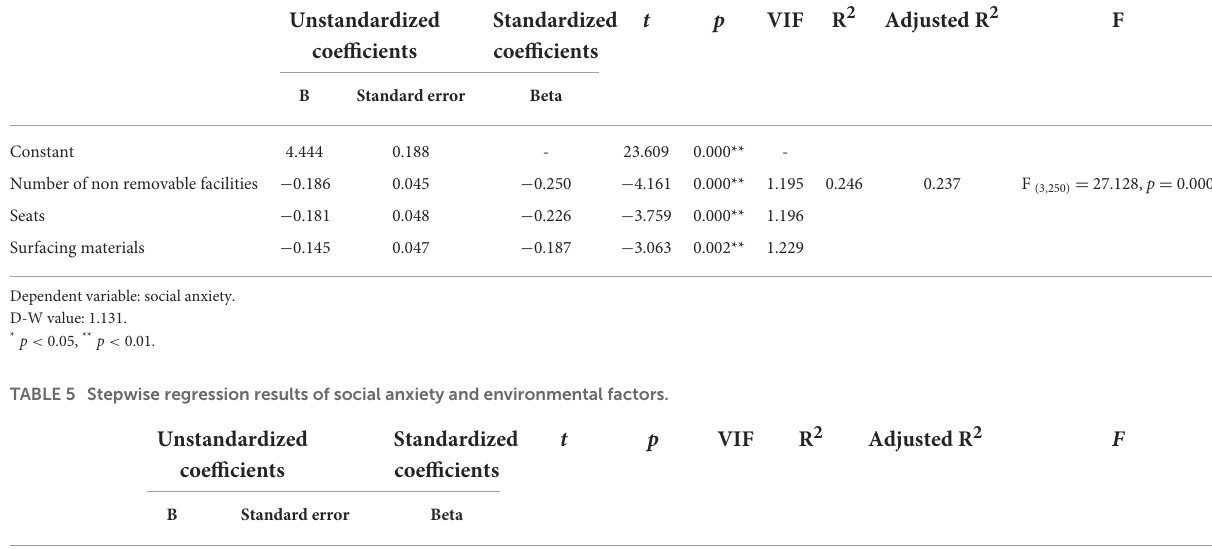
TABLE 4 Stepwise regression results of social anxiety and spatial elements.